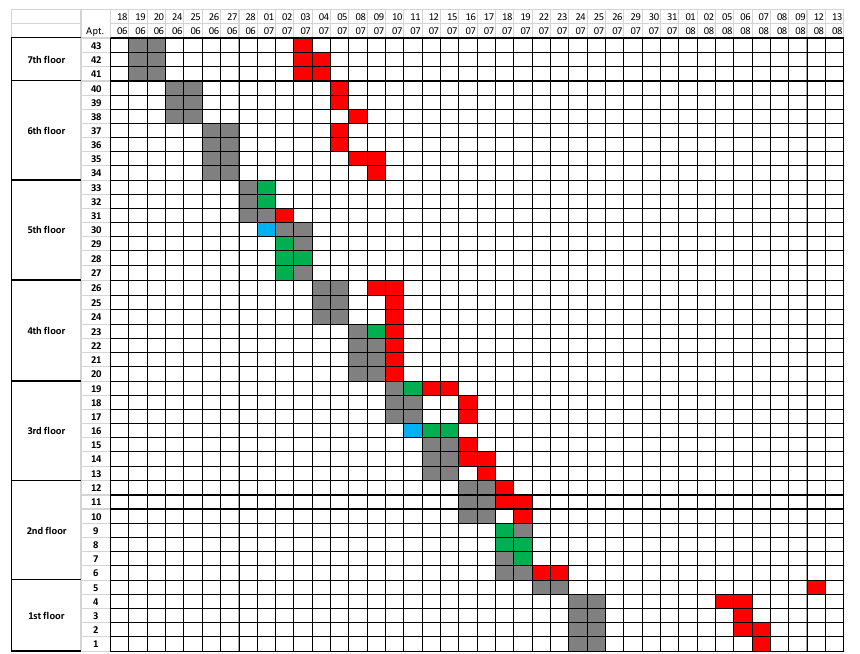
Figure 6. Actual documented realization of the installation of water pipes in each bathroom in the third building compared to the takt schedule. The red cells are work steps completed late, blue ones are early, and green ones on time.